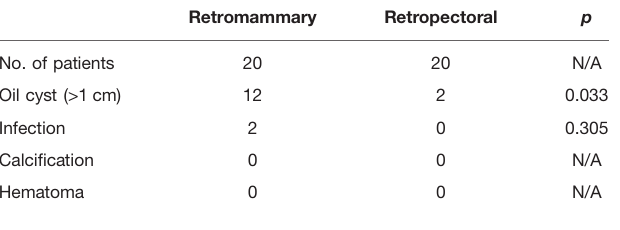
TABLE 2 | Complication